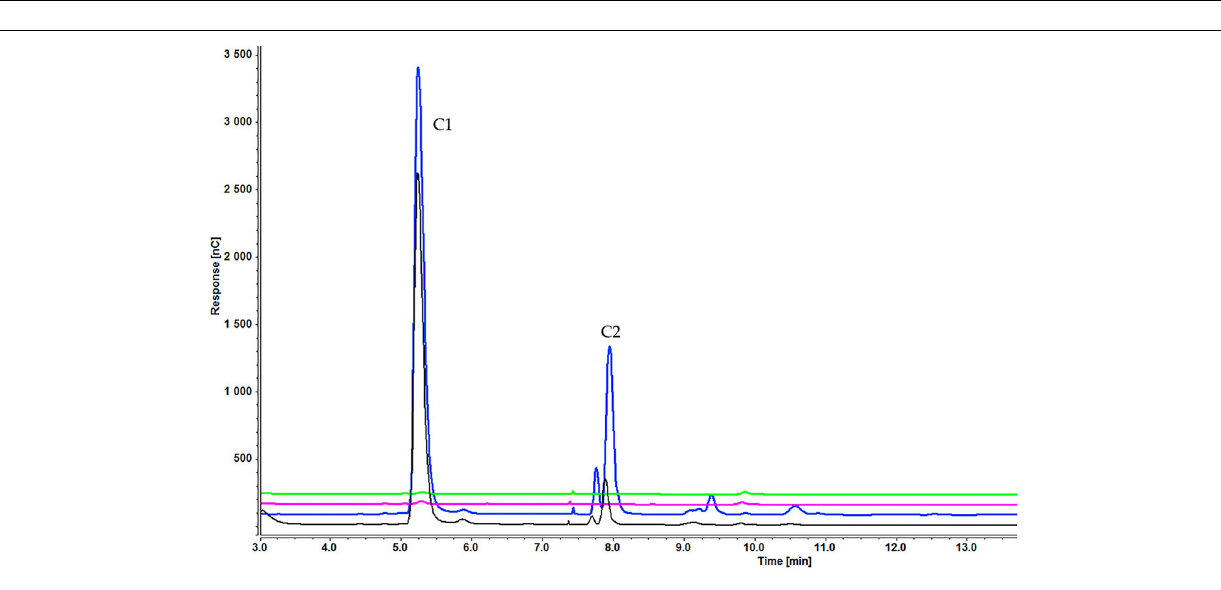
FIGURE 5 | Cellooligosaccharides concentration in the medium after 1 h (black), 3 h (blue), 5 h (pink), and 7 h (green) of induction with 0.2% cellotetraose (C1 = glucose, C2 = cellobiose). The figure of 0.1% cellotetraose ( Supplementary Figure S2 ) is presented in Supplementary Material